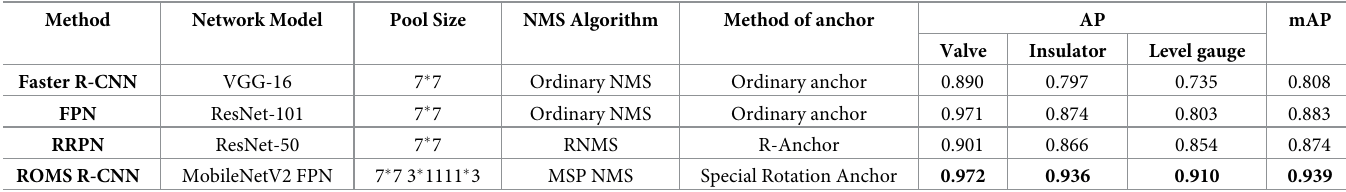
Table 5. mAP comparison table of three kinds of industrial equipment detected by different algorithms. Method